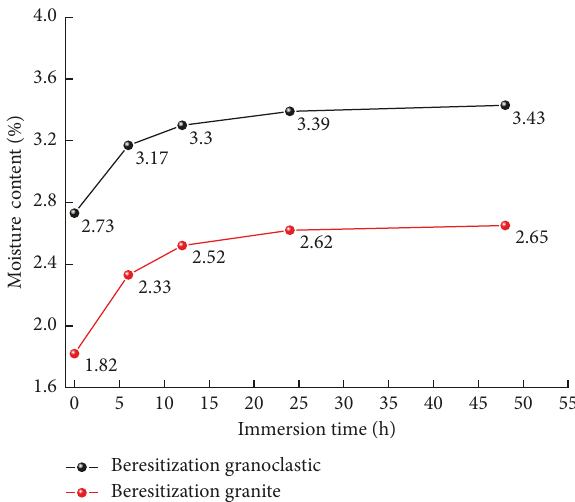
Figure 5: Test curve of the moisture